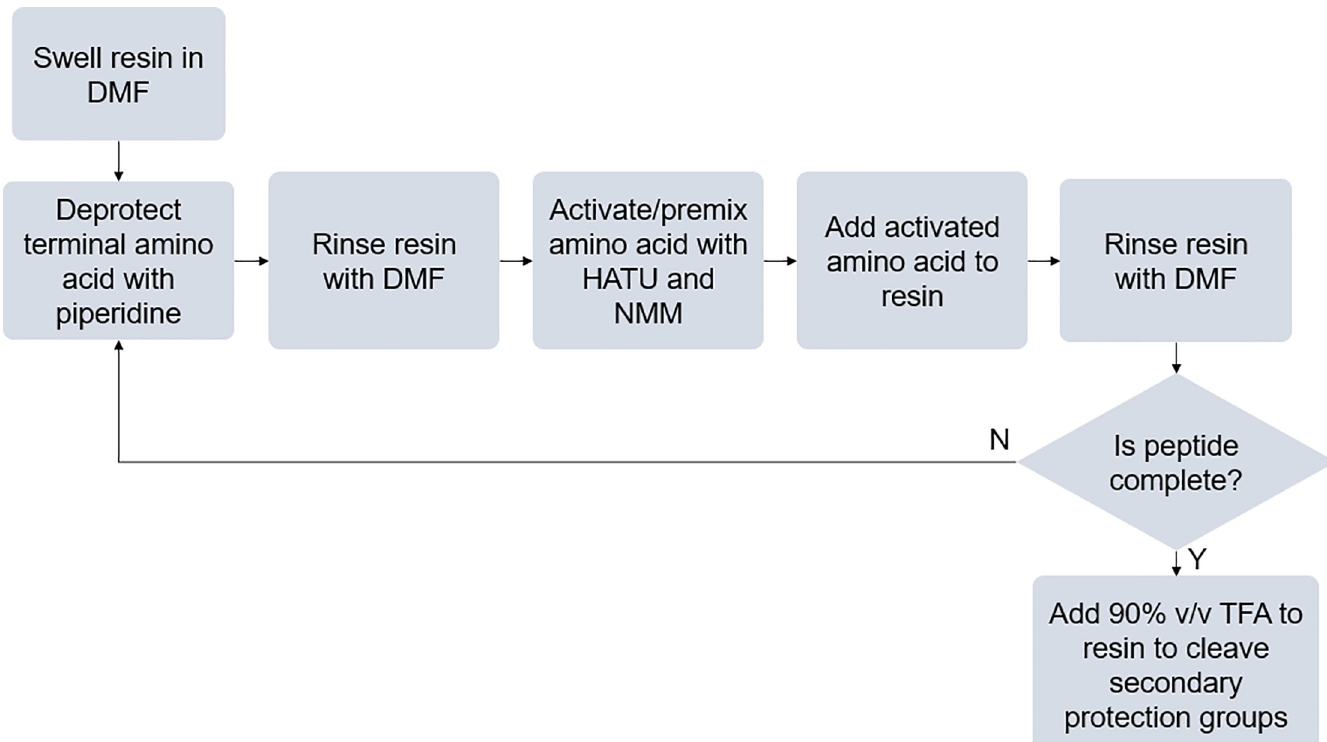
Fig 1. Process flow diagram of SPPS process, beginning with swelling of resin and ending with removal of side-chain protection groups.